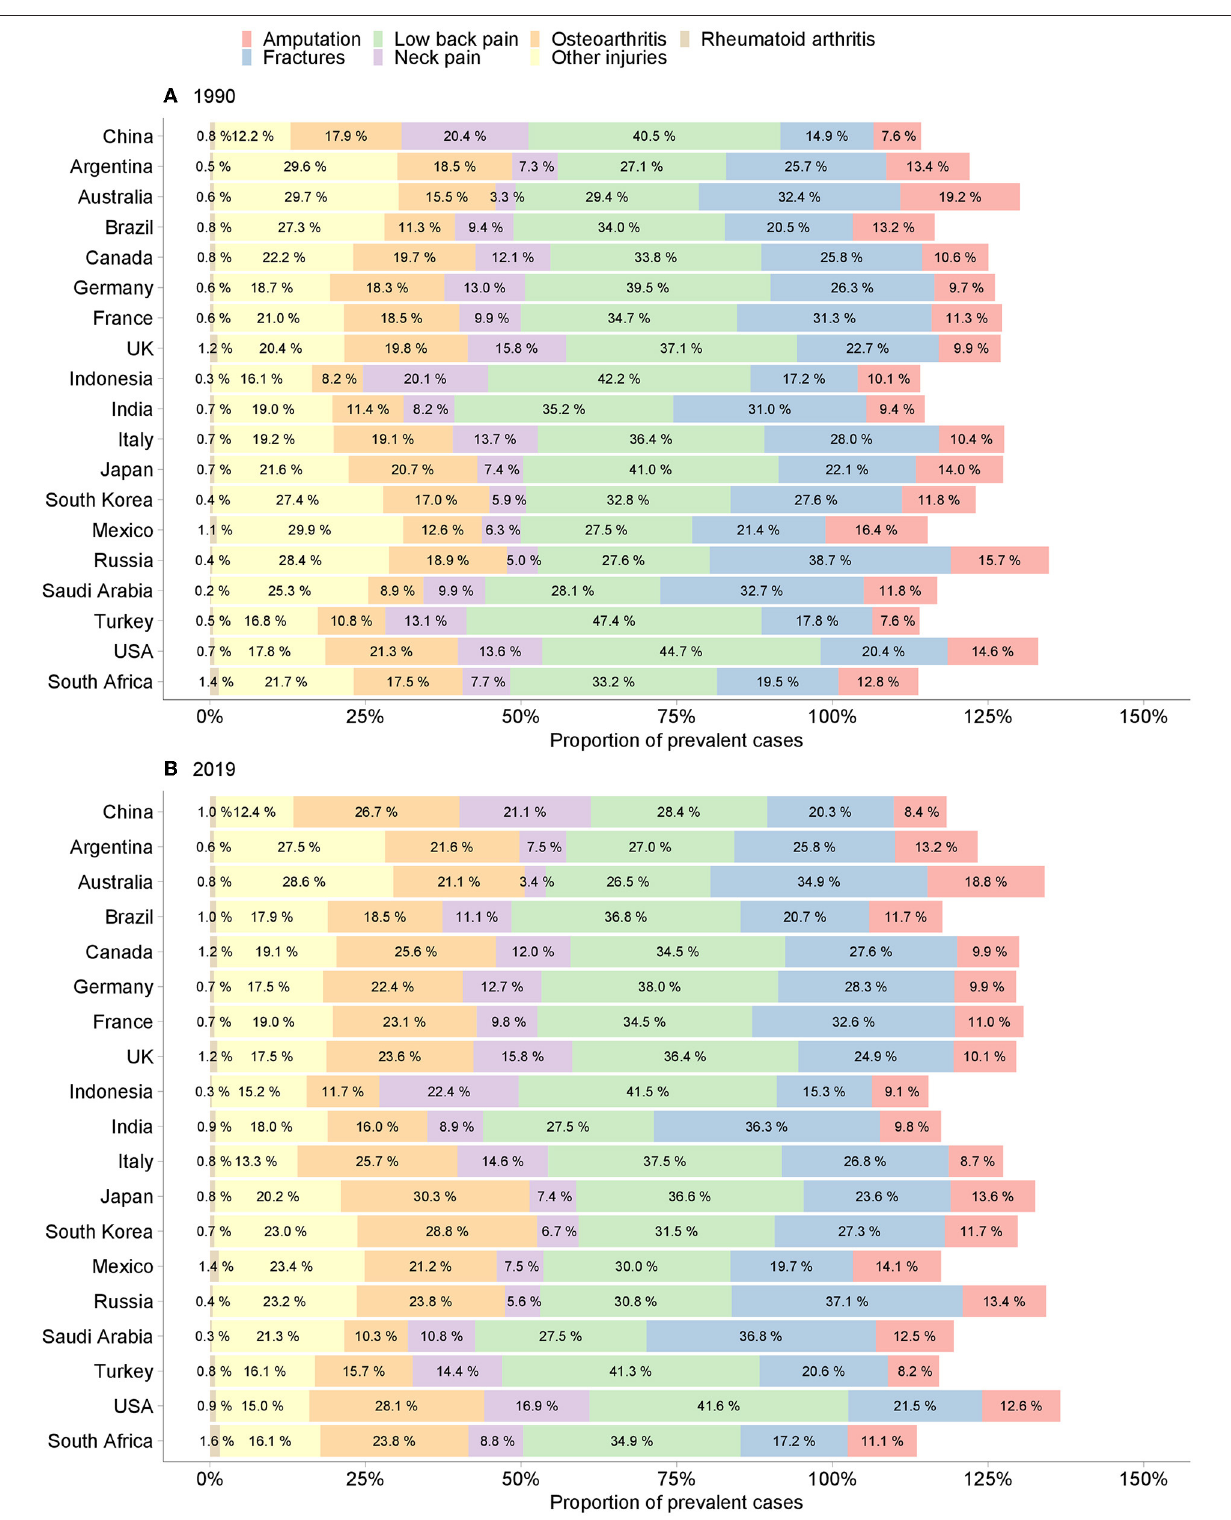
Frontiers in Public Health |